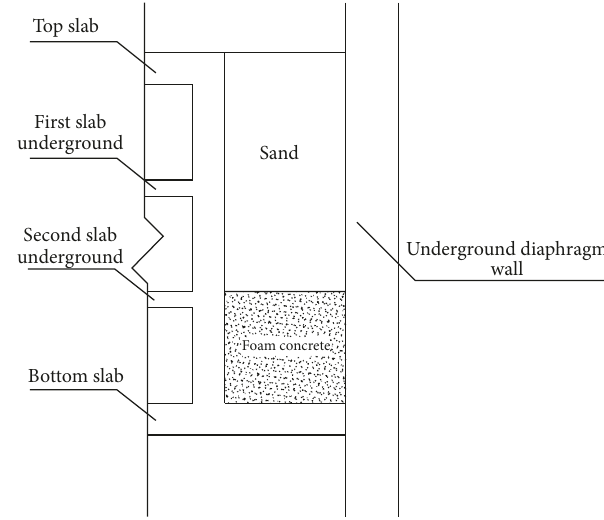
Figure 2: Sketch map of Scheme 1